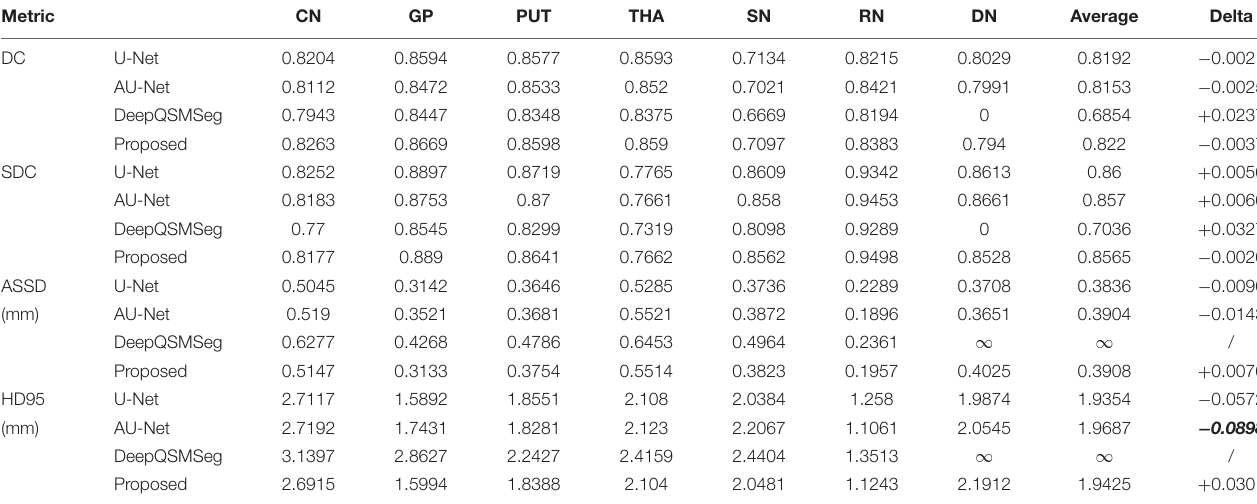
TABLE 4 | Segmentation performance on the test set of Dataset I without adopting TTA during inference. Metric